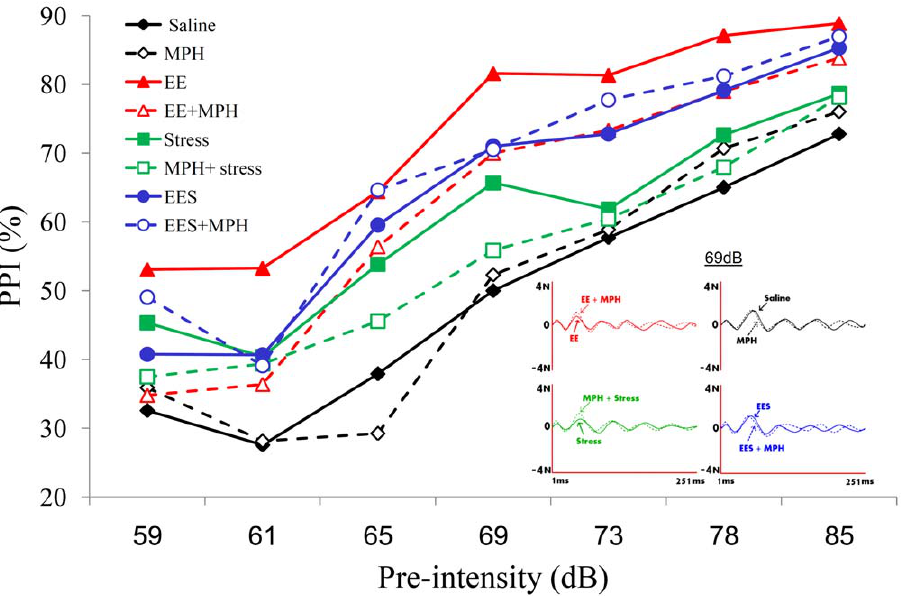
Figure 4. The effect of MPH on PPI. Significant differences in PPI scores were observed. EE led to the highest PPI compared with all groups ( P , 0.0001). Following MPH treatment, the EES group showed higher PPI compared with control ( P , 0.0001) and stress ( P , 0.001) groups. A panel of representative traces demonstrate the differences in maximal response inhibition (at pre-intensity of 69 dB) of all four groups, with and without MPH. n=9 to 10 per group.